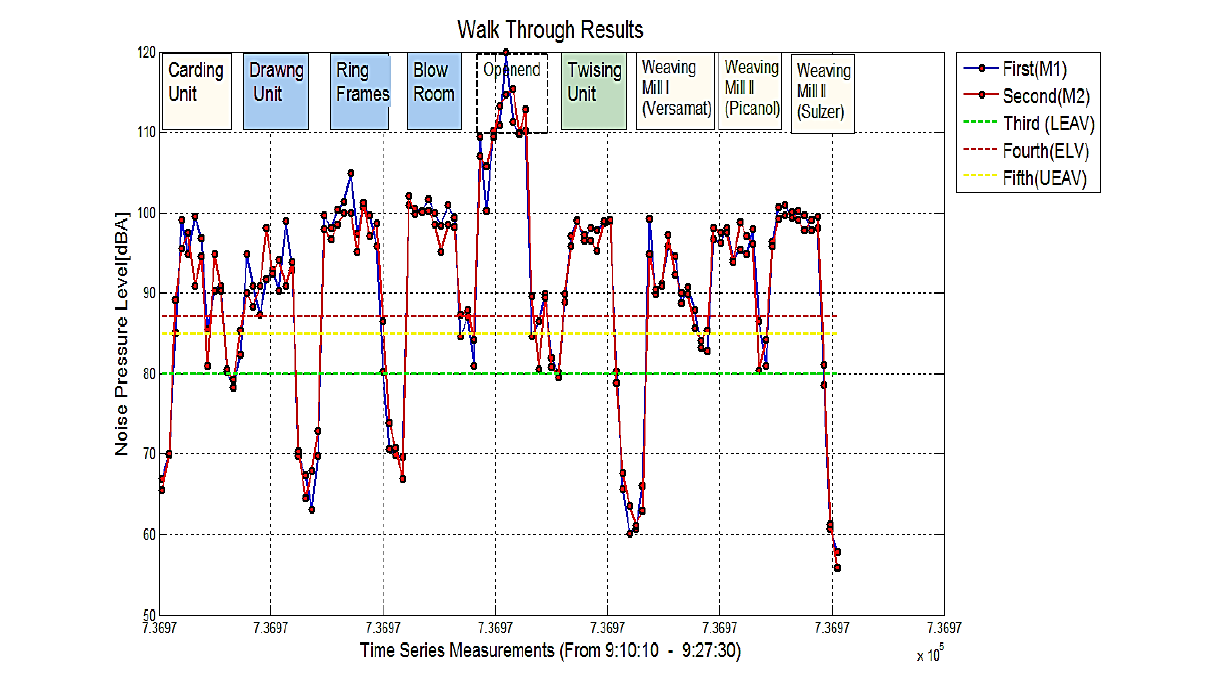
Figure 2. Noise pressure levels (L_Aeq) for walkthrough sound level measurements at the 105 measuring